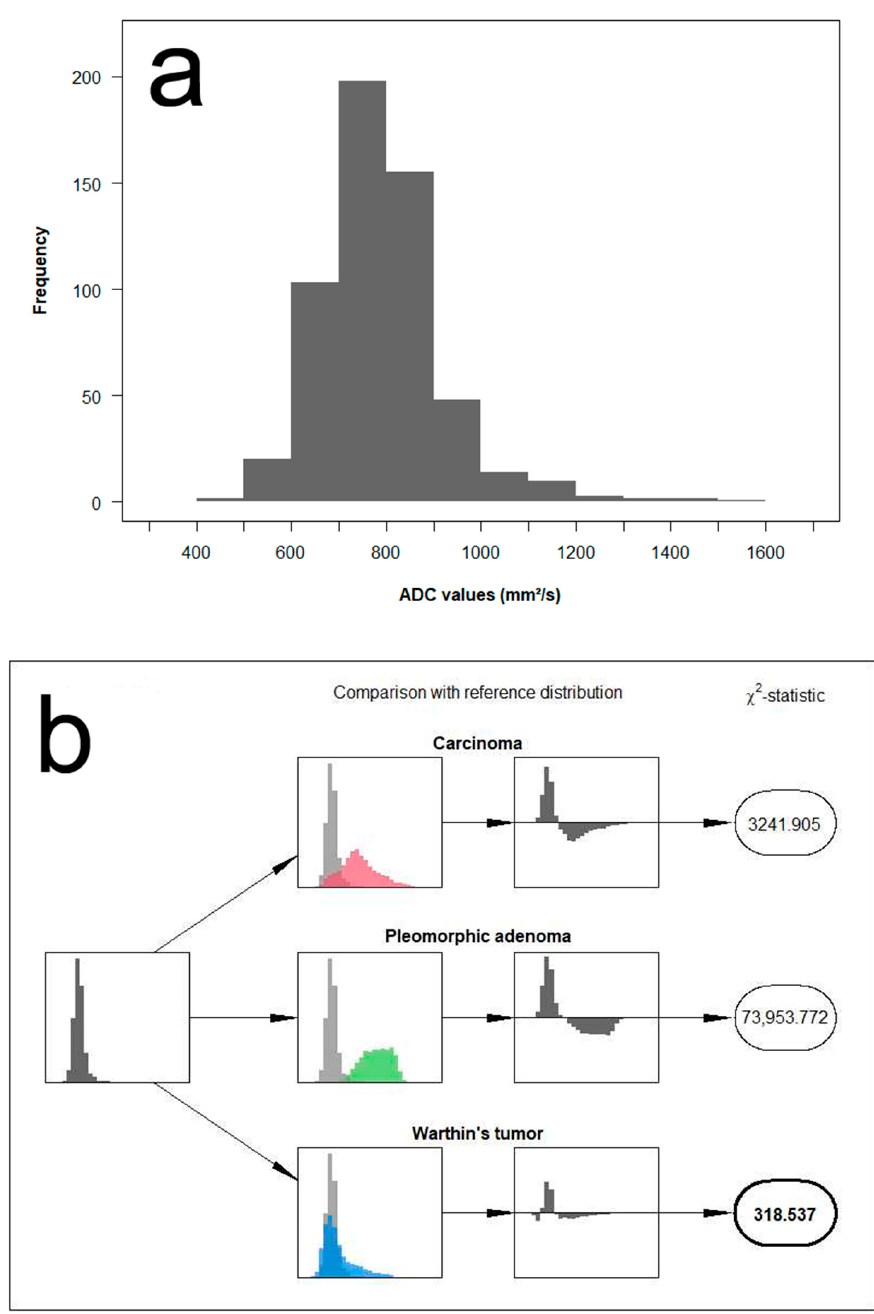
Figure 5. Example of histogram distribution derived from the patient of Figure 2. The image on the upper row ( a ) represents the full distribution of ADC values of a Warthin tumor. The image on the lower row ( b ) illustrates the analysis algorithm compromising a comparison of the measured ADC distribution to each of the three reference distributions using a Chi² test-statistic. In this example case, the test-statistic assumes a match with the reference distribution of Warthin tumors.